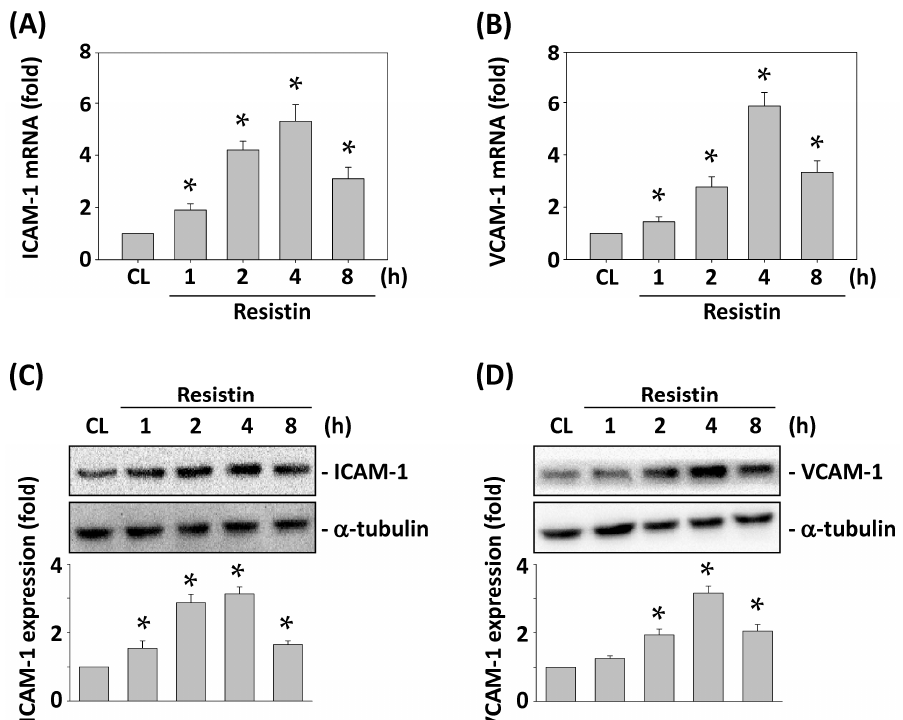
Figure 2. Resistin increases the expressions of ICAM-1 and VCAM-1 in HCT-116 cells. HCT-116 cells were maintained as control or stimulated with resistin. ICAM-1 and VCAM-1 mRNA ( A , B ) and protein ( C , D ) expression was analyzed. Data in ( A , B ) represent the mean ± SEM from three independent experiments. The results in ( C , D ) are representative of three independent experiments with similar results. * p < 0.05 vs. control cells.